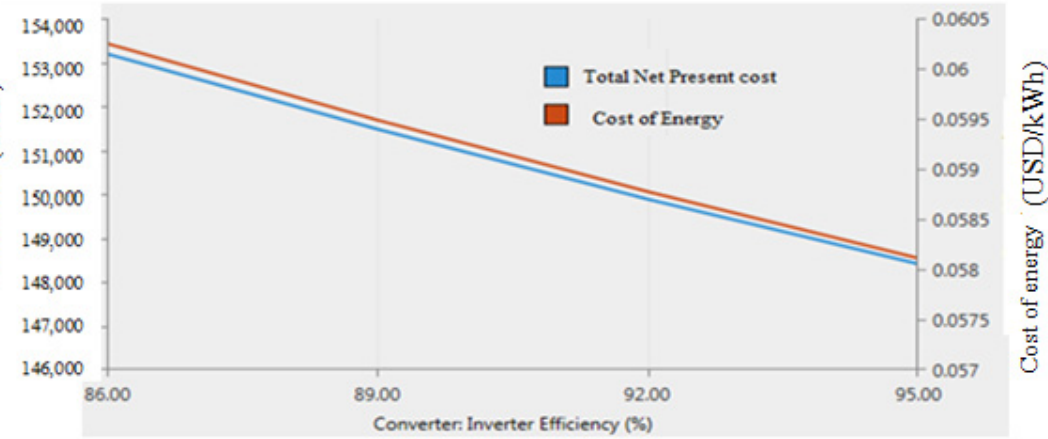
Figure 14. Effect of inverter efficiency change on the NPC and COE.